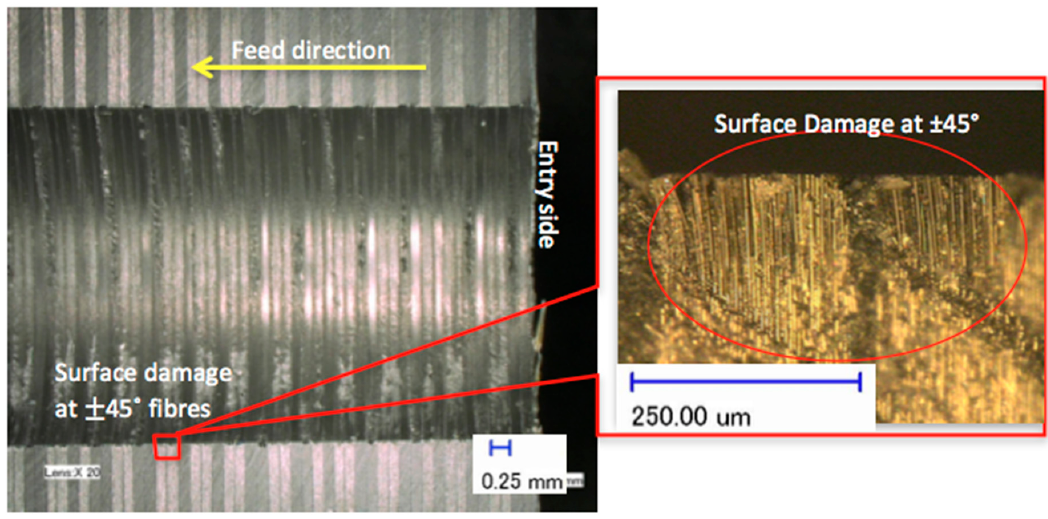
Figure 8. Drilling effect when the fibres were normal to the cutting direction.